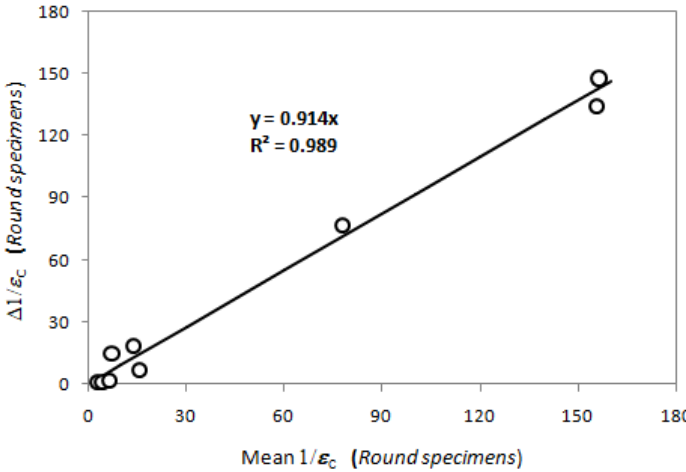
Figure 18. Span width ∆ 1/ ε c = (1/ ε c ) max − (1/ ε c ) min vs. the mean value of 1/ ε c for any Ni content (0.0, 0.7 and 1.5 wt%) and austempering conditions (380 ◦ C for 1 h; 310 ◦ C for 3 h; 250 ◦ C for 6 h) for the round specimens of the 25 mm Y-block